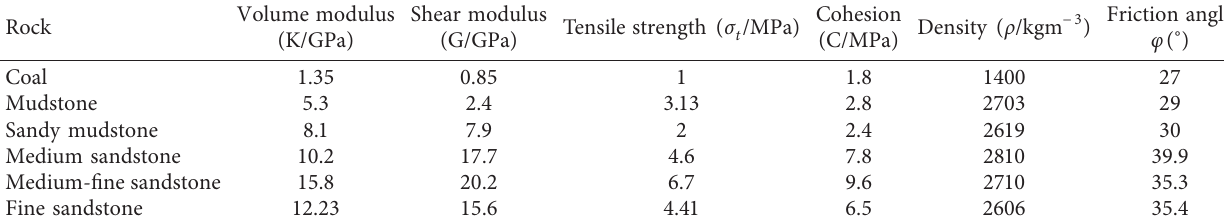
Table 1: Mechanical properties of various sediment